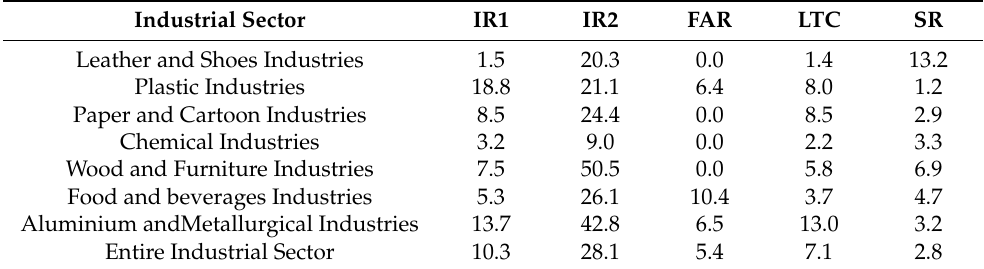
Table 7. Calculated US-OSHA rates for each industrial sector and the entire industrial sector for the period 2009–2016.